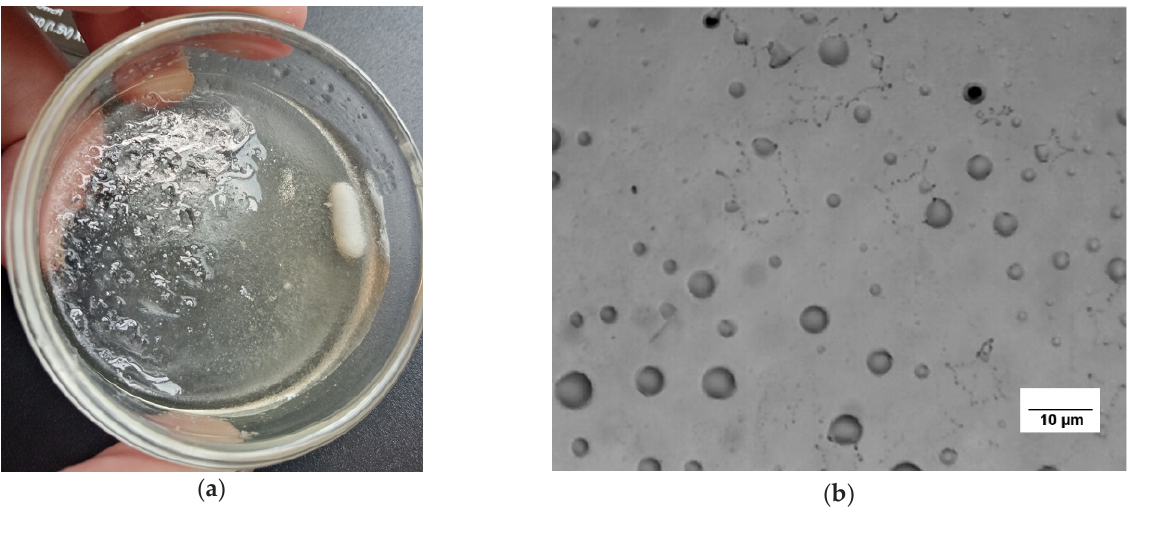
Figure 1. Petri dish (PD) containing CP1_1.1-Hgel obtained as described in Section 3.2 ( a ); optical microphotograph obtained analyzing hydrogel microparticles onto a glass surface ( b ).